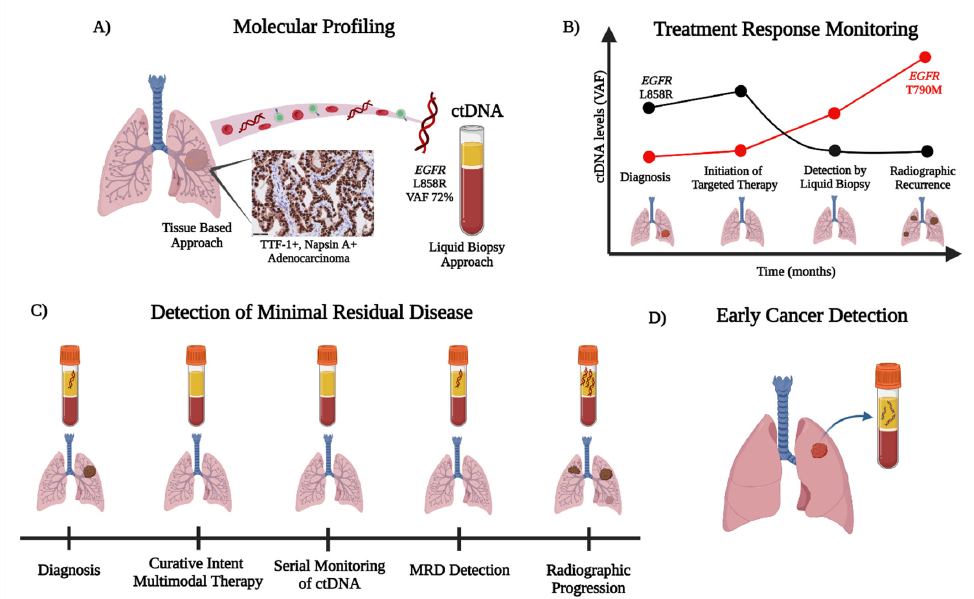
Figure 1. Overview of ctDNA detection and the workflow for NSCLC. The detection of ctDNA through liquid biopsies can be utilized for ( A ) molecular profiling, ( B ) treatment response